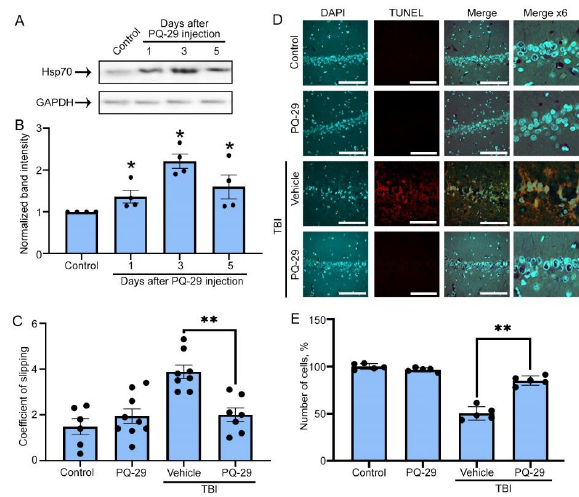
Figure 4. PQ-29 reduces post-traumatic neurodegeneration and saves motor function of traumatized rats. ( A ) The result of rat ’ s brain immunoblotting analysis. Brain lysates were stained with anti-Hsp70 and anti-GAPDH antibodies on one, three or five days after an intraperitoneal injection of PQ-29. ( B ) The result of band intensity quantification from section A is presented. The histogram bars show the average normalized band intensity of Hsp70 quantified based on three independent experiments. ( C ) Rats were anesthetized and divided into four groups: TBI groups were traumatized, the other two groups were not. The PQ-29 groups were treated with intraperitoneal PQ-29 injections three times a week. DMSO was used as a vehicle. The beam walking test was employed to define the changes in locomotor function, as described in the text. The coefficient of slipping defines the height of the histogram bars. ( D ) The confocal microscopy data are presented. Rats ’ brains from different groups, as described in section A, were sliced and stained with 4′,6 -diamidino-2-phenylindole (DAPI) (cyan) and Click-It TUNEL kit (red). The CA1 hippocampus field is shown. Scale bar 10 µm. ( E ) The number of cell nuclei stained with DAPI was normalized to that in hippocampus of control animals and presented as histogram bars. For each group, no less than 500 cells were counted. Data presented as mean ± SEM. Statistical significance is indicated as * p < 0.05 and ** p < 0.01.